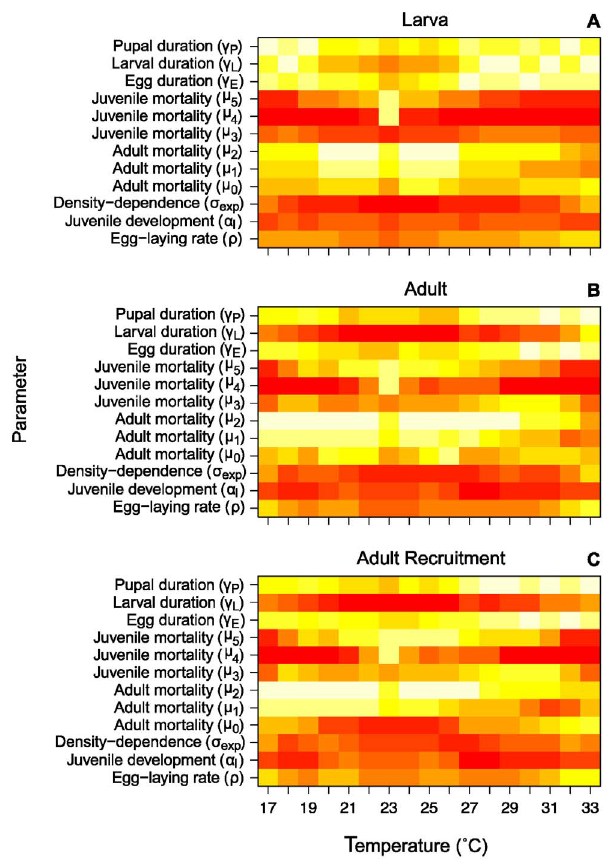
Figure 6. Sensitivity rank across temperature. The sensitivity of larval abundance (A), adult abundance (B) and adult recruitment (C) to changes in the parameters across temperatures ranked from highest to lowest sensitivity. Red indicates greatest sensitivity to change, followed by orange, yellow and white. The x-axis is temperature from 17–33 u C, and the y-axis is the parameter.